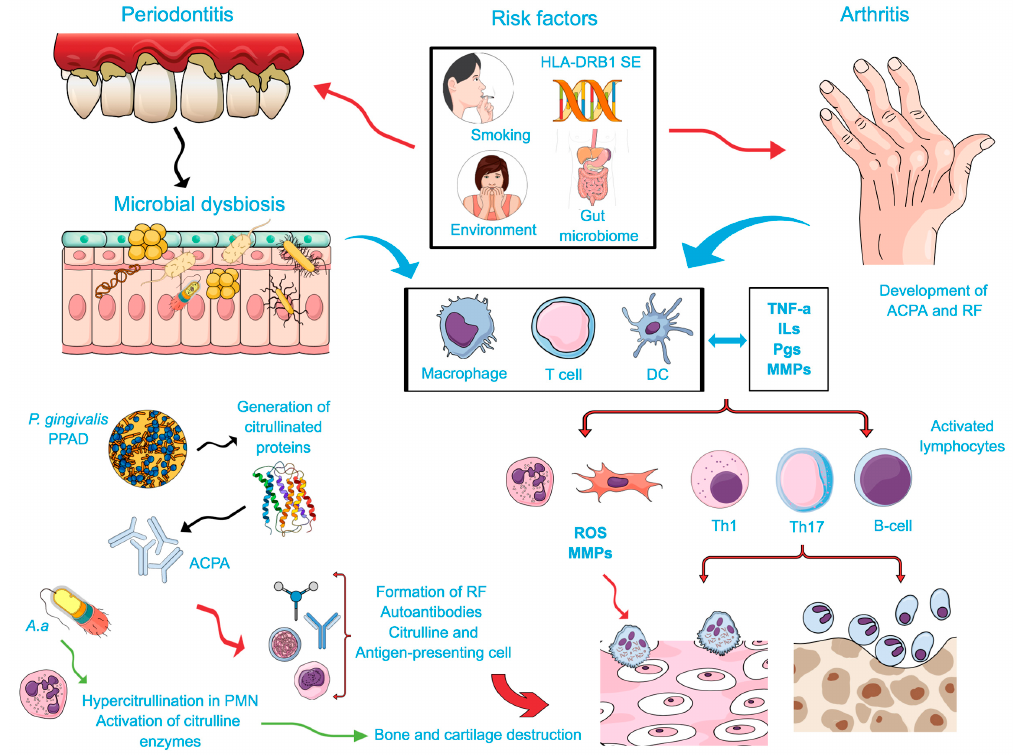
Figure 1. Possible biological intersections between rheumatoid arthritis (RA) and periodontal disease (PD): Common risk/predisposing factors and reciprocal biological influences. The exposure to certain environmental factors, e.g., smoking, genetic background (HLA-DRB1-SE), gut microbiome, infection with P. gingivalis and more recently with A. actinomycetemcomitans (microbial dysbiosis) leads to local protein alteration by citrullination. In combination with an inflammatory process stimulated by macrophages, dendritic cells, and T cells, a host response to citrullinated proteins in predisposed patients will occur. Immune cells will produce proinflammatory mediators (Interleukins (ILs), Prostaglandins (PGs), Tumor Necrosis Factor (TNF), and metalloproteinases (MMPs), which also contribute to the aggravation of the immune response. IL-17, an important cytokine of the Th17 induces the production of CXC chemokines, MMPs, and reactive oxygen species (ROS), as well as the osteoblast expression of the receptor activator of the factor nuclear kappa B ligand (RANK-L) that stimulate osteoclast activation. Stimulated lymphocytes (B and T cells, specifically Th1 and Th17) play an important function during bone resorption by means of the RANKL-dependent mechanism in both conditions. P. gingivalis infection lead to the activation of proteases and peptidylarginine deiminase (PPADs) that generates citrullinated proteins and triggers the synthesis of anti-citrullinated proteins antibodies (ACPAs). A resultant signal against citrullinated epitopes in the joints resulting in enhanced expression of the rheumatoid factor (RF) and ACPAs, assisting in the formation of immune complexes. A. actinomycetemcomitans lead to the hypercitrullination of neutrophils and result in the activation of citrulline enzymes, which are also involved in the breakdown of the immune tolerance to the host molecules. These immune complexes enhance the host inflammatory development, which may aggravate RA. In addition, the autoantibodies produced during this process might contribute to the inflammatory process by directly activating osteoclast and resulting in the bone and cartilage damage. Thus, citrullination may represent a biological mechanism bridging reciprocal influences between RA and PD.